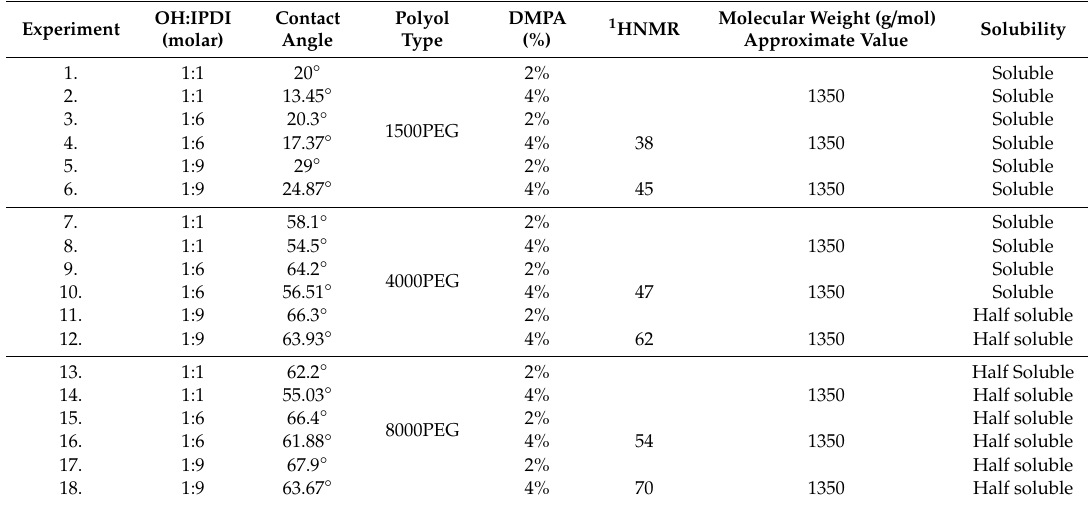
Table 1. Molecular weight, OH:IPDI molar ratio, and the water solubility of each samples. Experiment